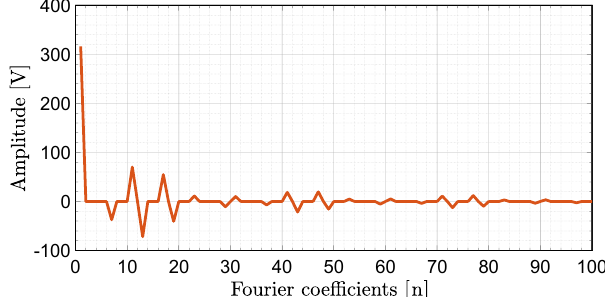
Figure 8. The fourier series coefficients ( a n ).